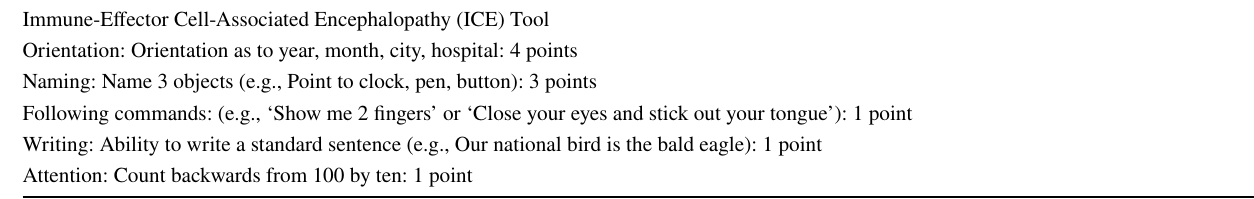
Table 2 ICE Tool [9]